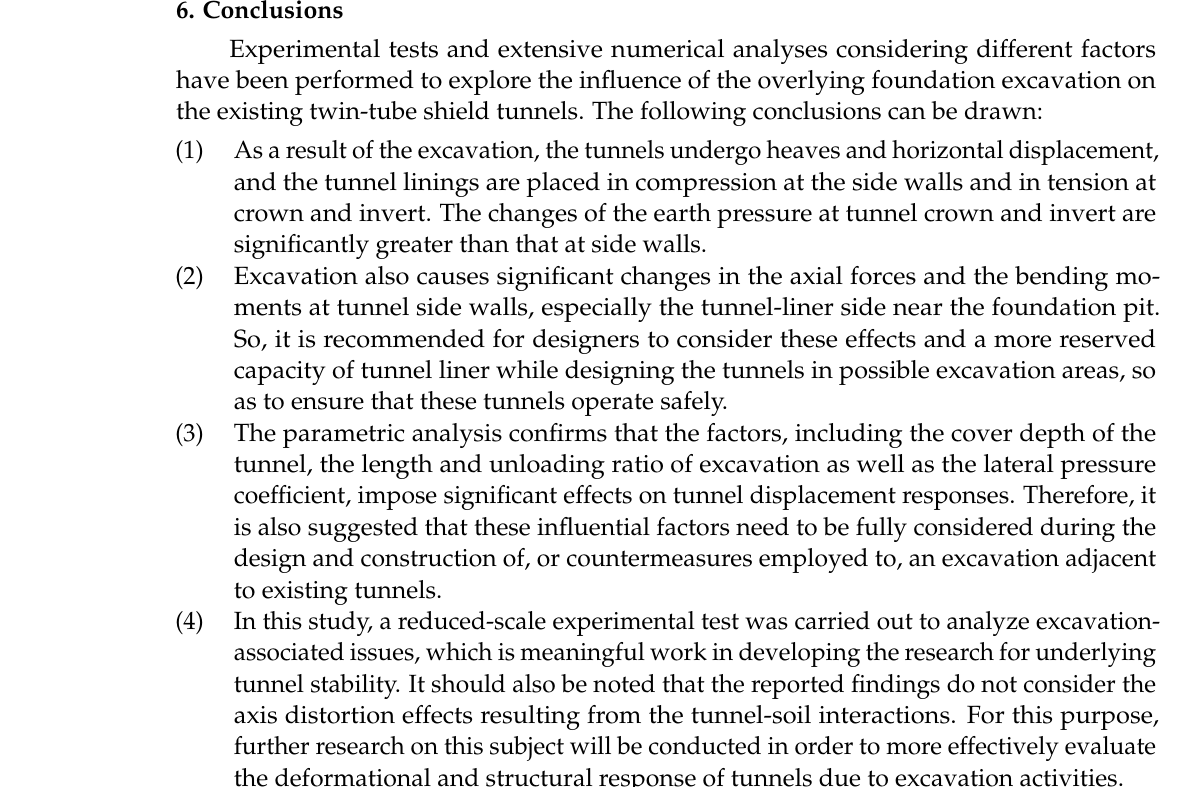
Figure 19. Influence of K 0 on tunnel displacement.